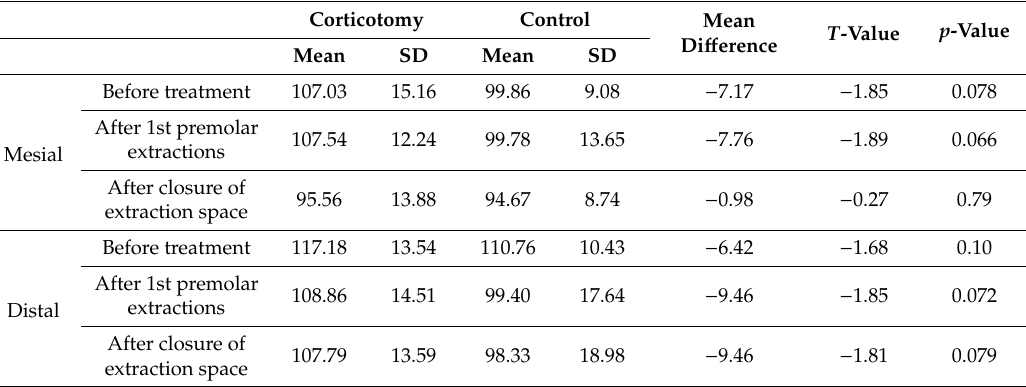
Table 6. Descriptive statistics of bone densities in both sides before treatment, after extraction and after the closure of the extraction space (HU